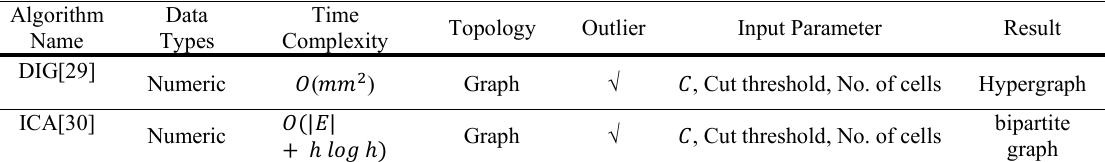
Table 4. Graph-Based Algorithms Common